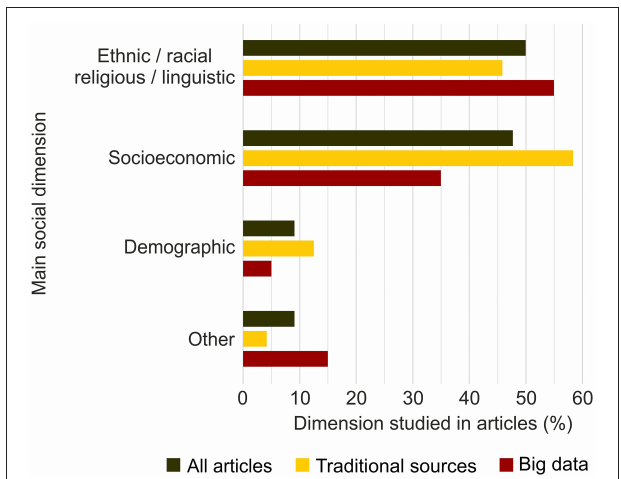
FIGURE 6 | Distribution of main social dimensions along which activity space segregation was studied in all articles ( n = 44), and in articles using traditional data sources ( n = 24) and big data sources ( n =